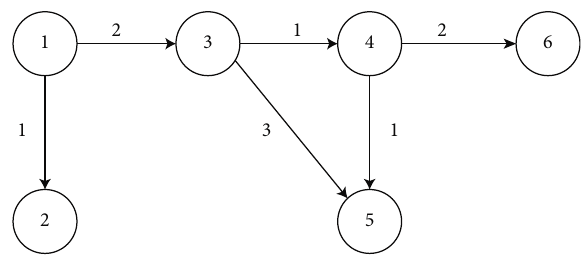
Figure 1: Topology of the graph G